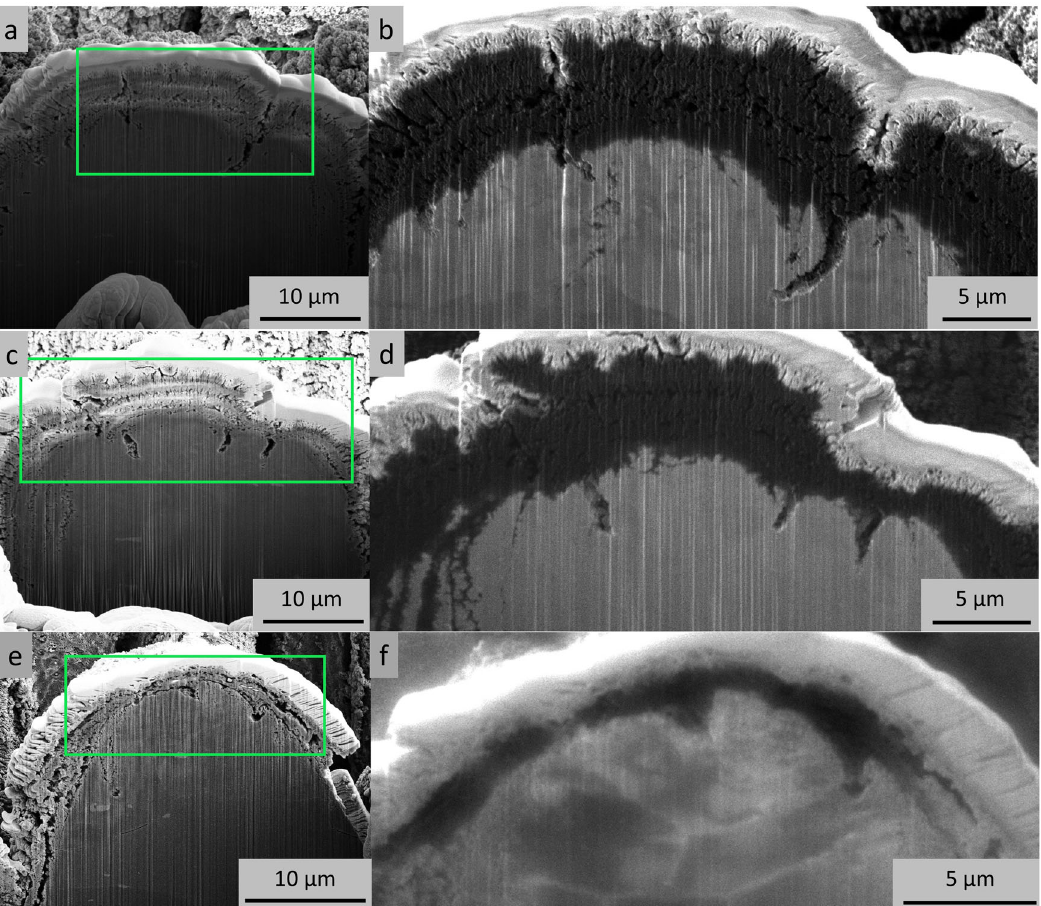
Fig. 4 Cross-sectional images of three samples processed in open air at the same pulse count and fl uence to compare the oxide layer thickness for different amounts of etching. The cross section in a and b was performed directly after laser processing. The remaining samples were acid etched, in a 2% solution for 20 min ( c , d ) and a 10% solution for 60 min ( e , f ). The green boxes in the SEM images of a , c and e illustrate the zoomed area for the pictures shown in b , d and f , respectively. b , d and f are images produced using the ion beam as the illumination source, which causes the oxide layer to appear black. The bright layer on top of the oxide is a thin protective platinum layer added before the